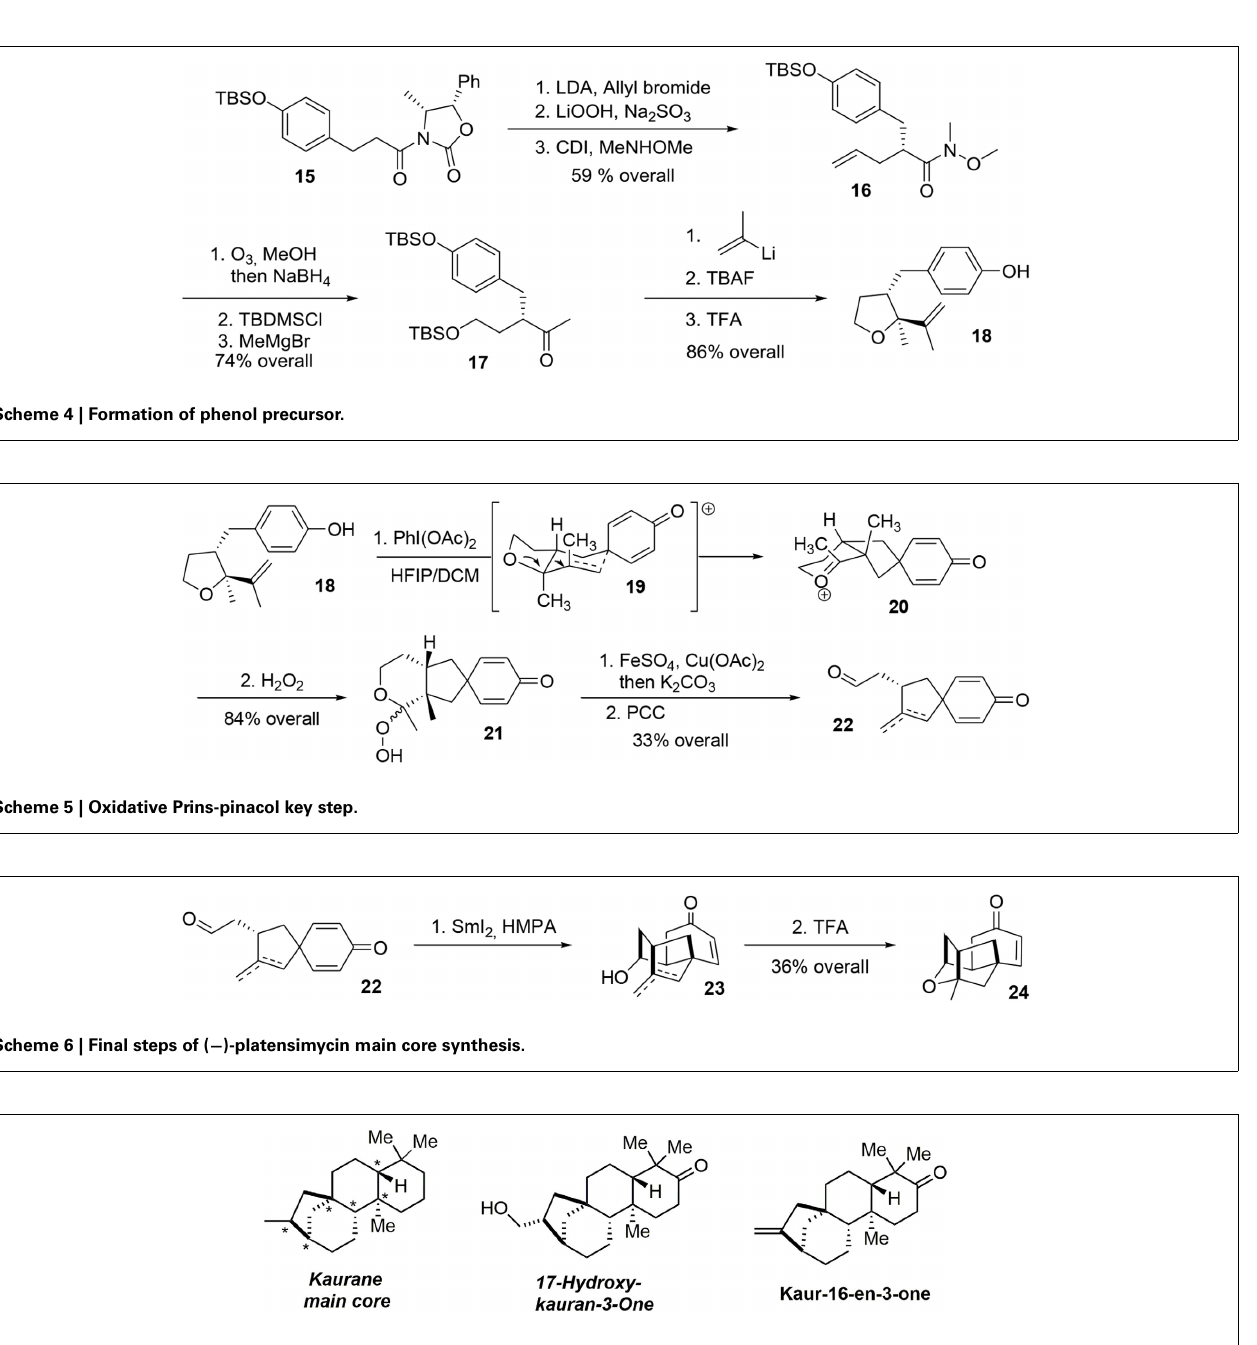
FIGURE 5 | Kauran diterpen